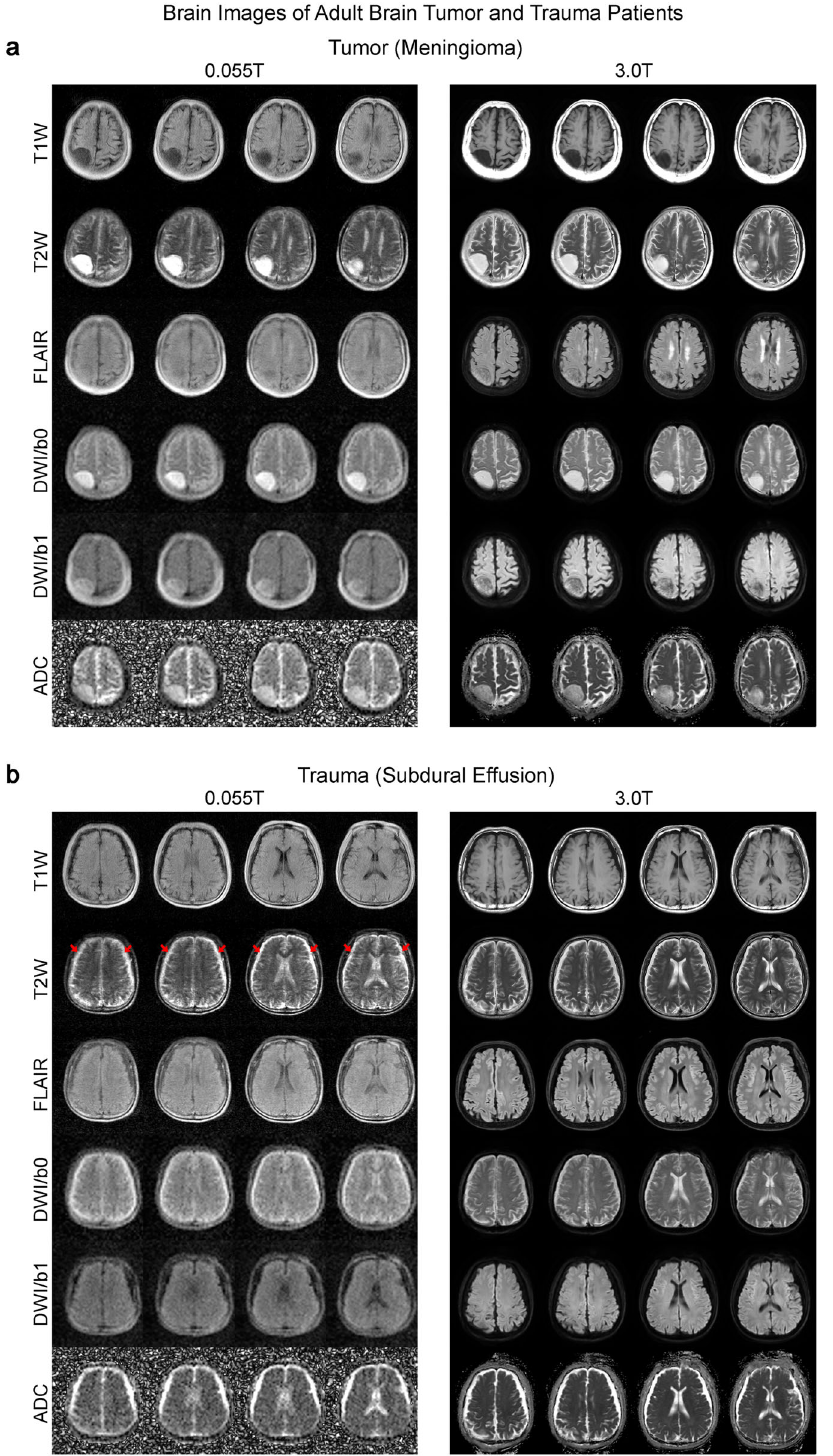
Fig. 6 Clinical utility of 0.055 T MRI for examining tumor and trauma patients. Total scan time was ~30 mins for T1W, T2W, FLAIR and DWI protocols for each patient at 0.055 T. Both patients were scanned by 3 T MRI on the same day using the standard T1W, T2W, FLAIR and DWI brain protocols (~20 mins total scan time) for comparison. a Patient (75 yrs. old; female) with an extra-axial mass (i.e., meningioma) at the right parietal cortex. Both 0.055 T and 3 T images showed that the tumor mass was hypointense in T1W and hyperintense in T2W. b Patient (64 yrs. old; male) with subdural effusion (i.e., collection of cerebrospinal fl uid, CSF, trapped between the surface of the brain and the dura matter) due to previous head trauma. The subdural collection with sulci obliteration showing as a bright signal in T2W images (indicated by red arrows) was visible at bilateral fronto-parietal